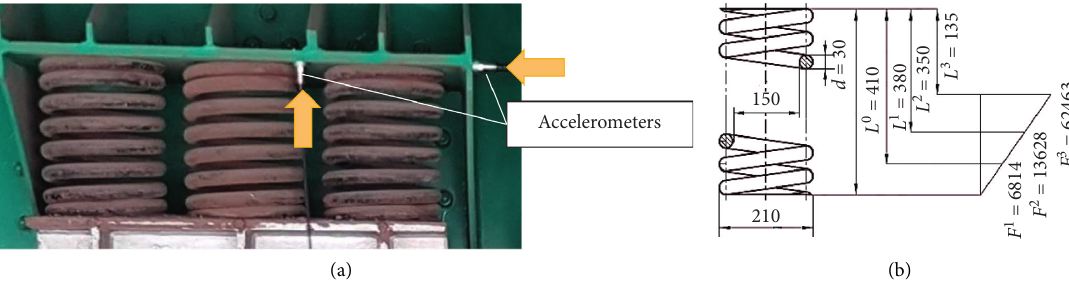
Figure 2: Supporting unit with three springs and vibration sensors (a); geometry and deformations of a single helical spring